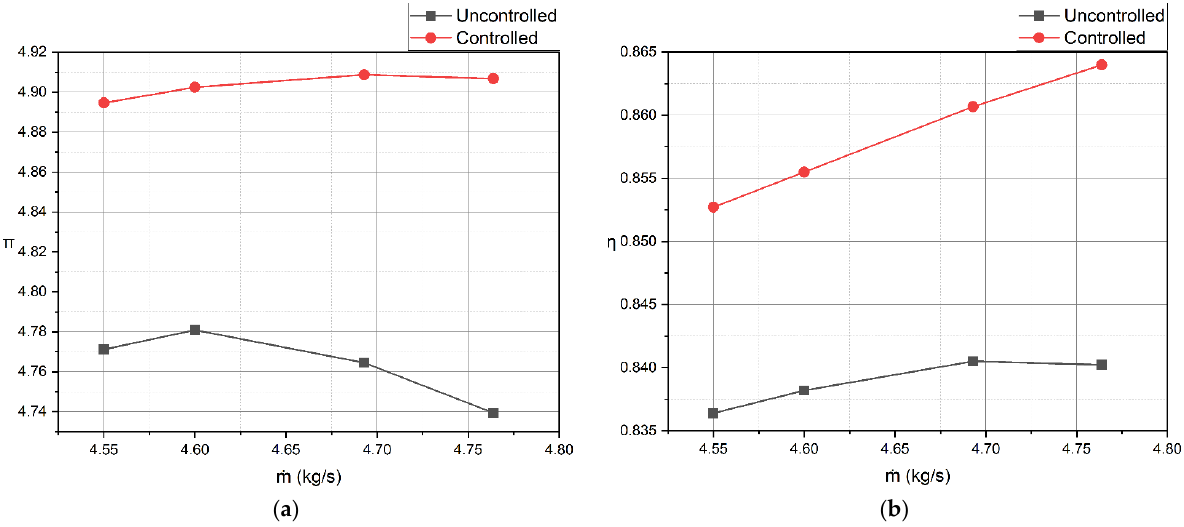
Figure 9. Results for controlled and uncontrolled cases near stall flow rate: ( a ) pressure ratio, π; ( b ) adiabatic efficiency, η.